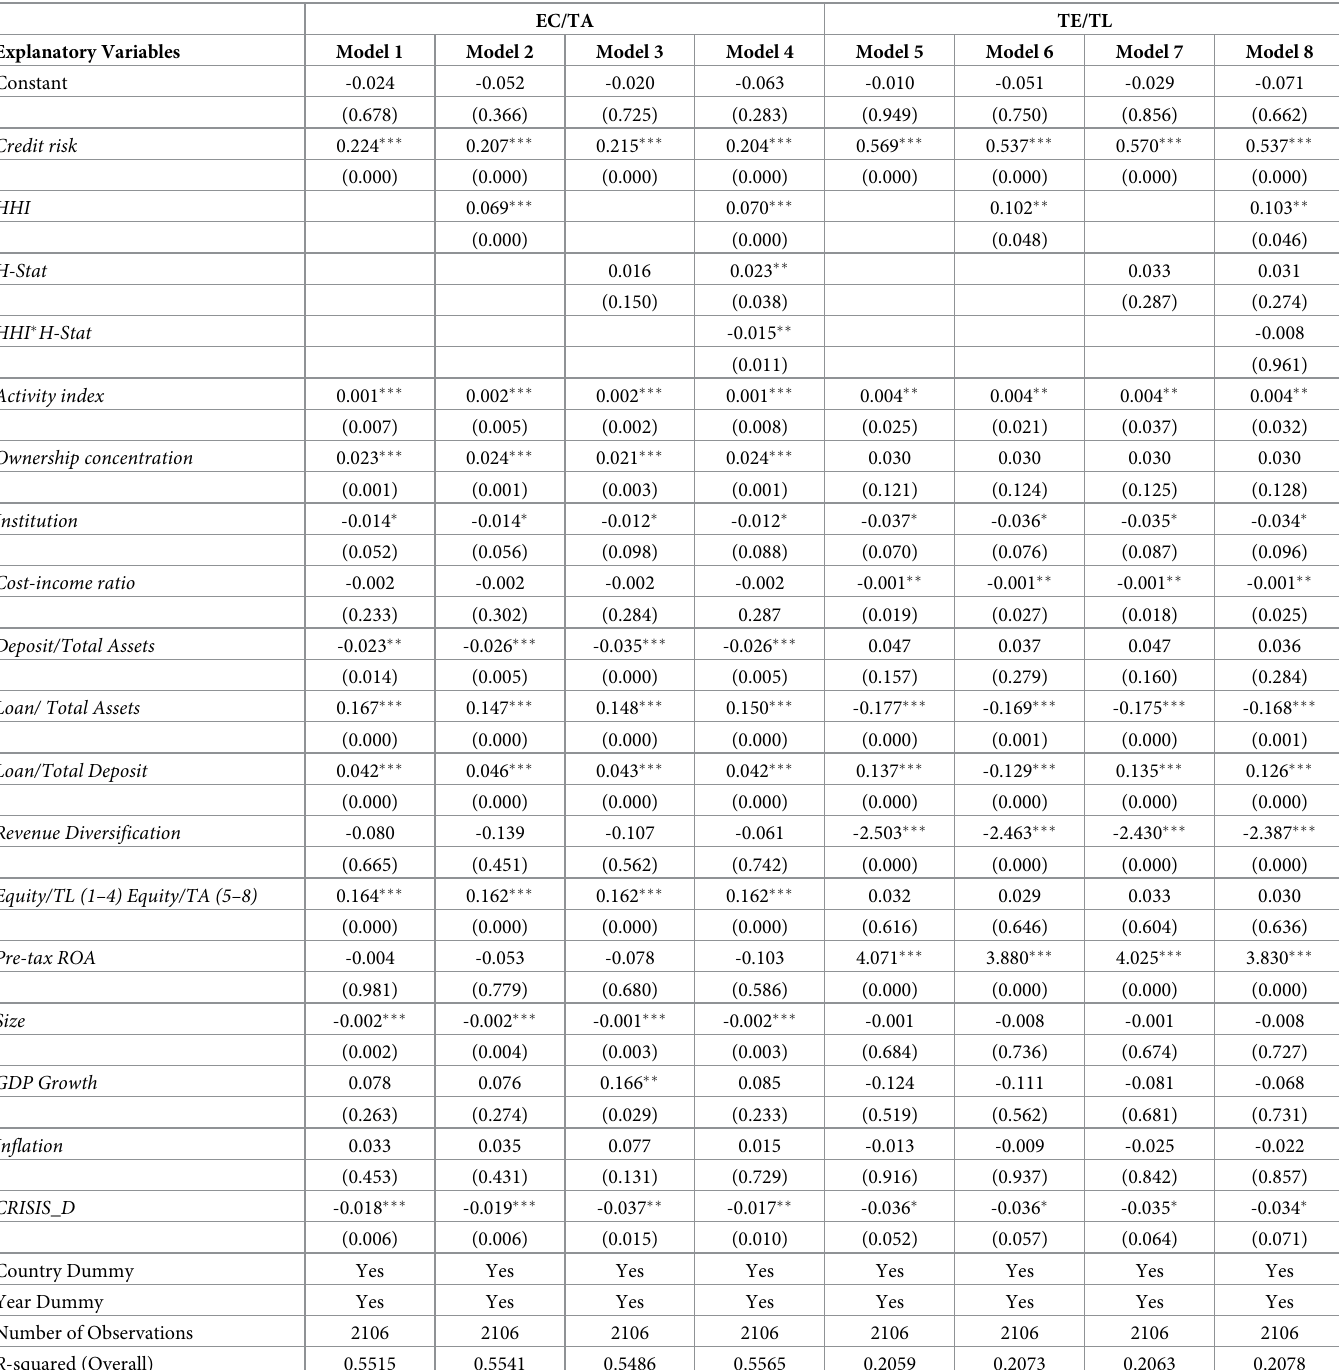
Table 4. Panel regressions of competition and capital ratio (CBs,